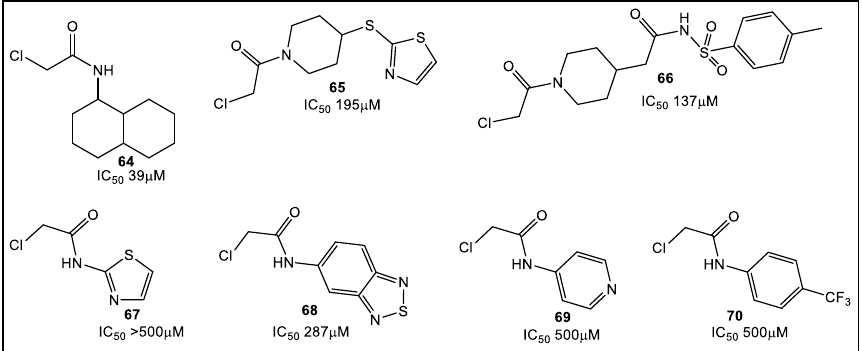
Figure 12. Illustrative examples of chloroacetamide-based covalent inhibitors for MurA from E. coli (Mur EC ) identified by LC-MS/MS and biochemical assays. Fragment 64 was identified as the most effective inhibitor that binds to MurA Cys115. Inhibition of MurA EC by these fragments appears not to be associated with their thiol reactivity, as per evaluation of fragments’ electrophilicity using the Ellman reagent (reduced) as a proxy for cysteine thiol. This suggests the possibility for their further development as inhibitors of the MurA enzymes.